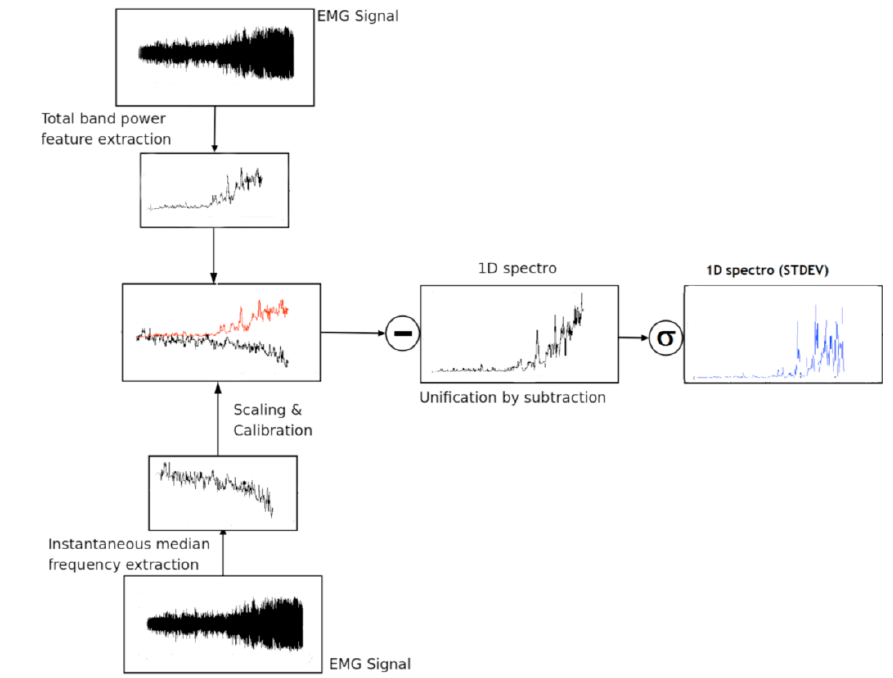
Figure 3. An illustration on constructing the 1D spectro_std feature.